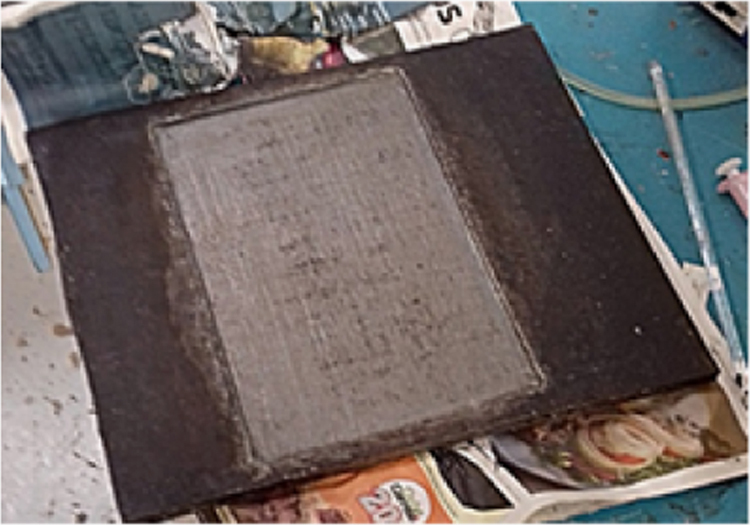
Composite laminate.